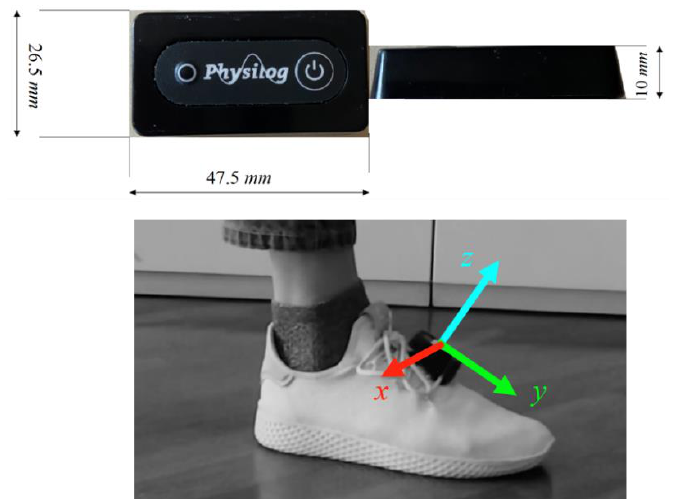
Figure 1. GaitUp Physilog size ( top ) and placement on the foot ( bottom ). Direction of the local right-handed reference frame axes is also reported.